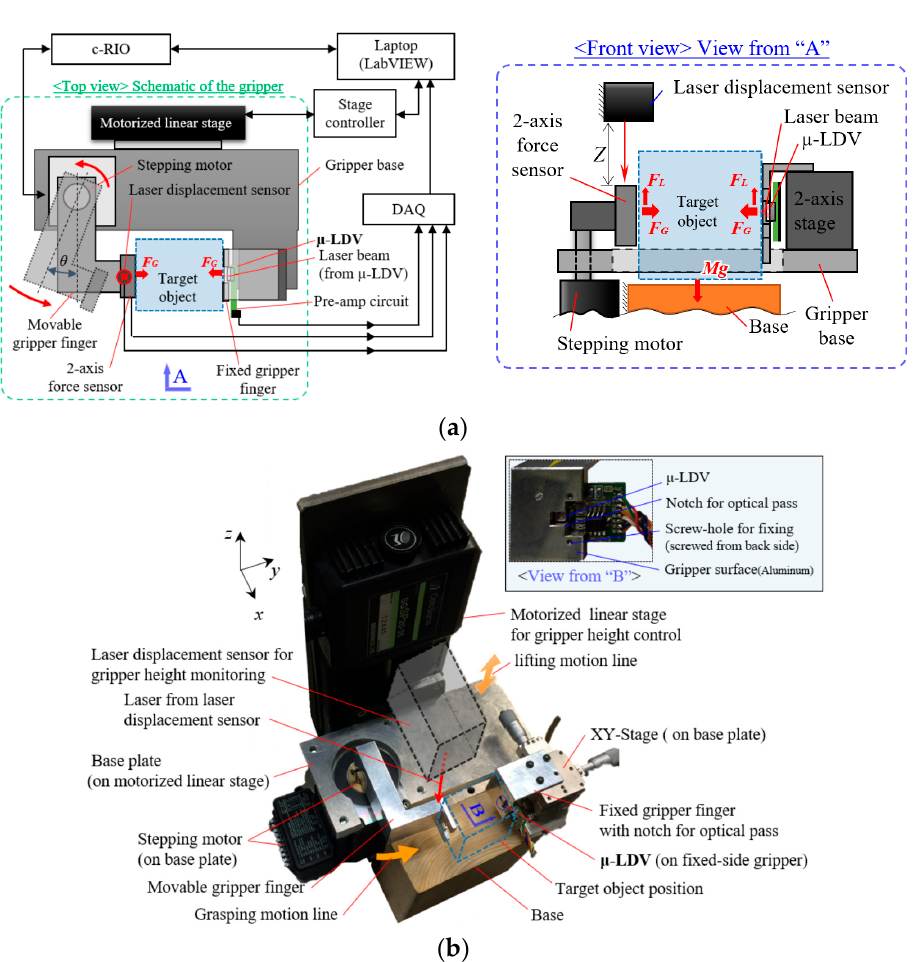
Figure 7. Experimental setup: ( a ) A schematic of experimental setup. Grasping motion is controlled by a stepping motor, operated by LabVIEW via c-RIO interface. Gripper height is controlled by a motorized linear stage, operated by LabVIEW via stage controller interface. Output signals of the µ -LDV, two-axis force sensor, and a laser displacement sensor for gripper height monitoring are processed and recorded by LabVIEW via DAQ interface. The figure at the right side shows the front view (from the view point “A”), with the relation of force vectors on target object. Motorized linear stage is omitted; ( b ) a picture of gripper setup. A laser displacement sensor and a target object are additionally illustrated. The µ -LDV is fixed on L-shaped gripper with a notch for optical path. Inset shows description around the µ -LDV from the view point